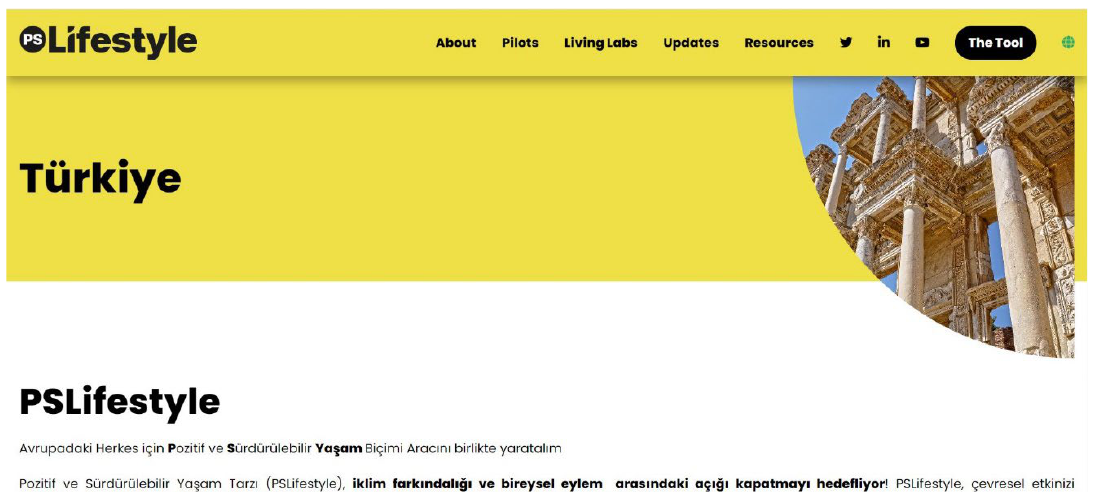
Figure 4 PSLifestyle (web-based tool) (Url-4)